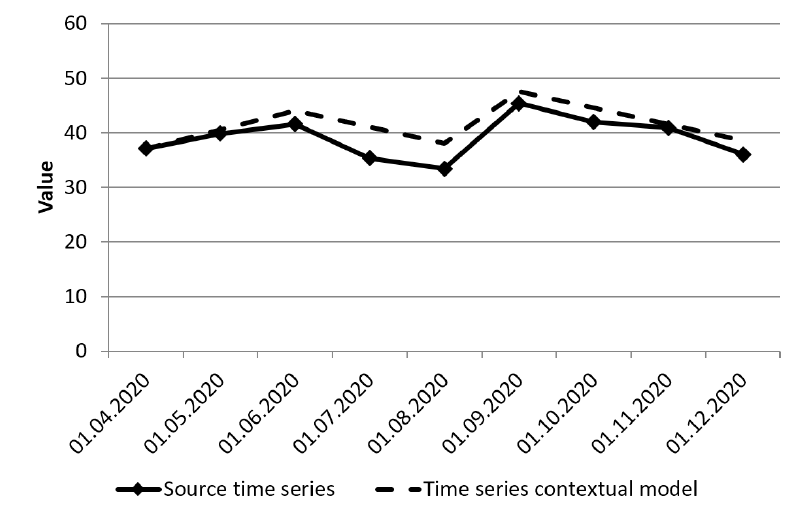
Figure 4. Time series representation based on the rule set.